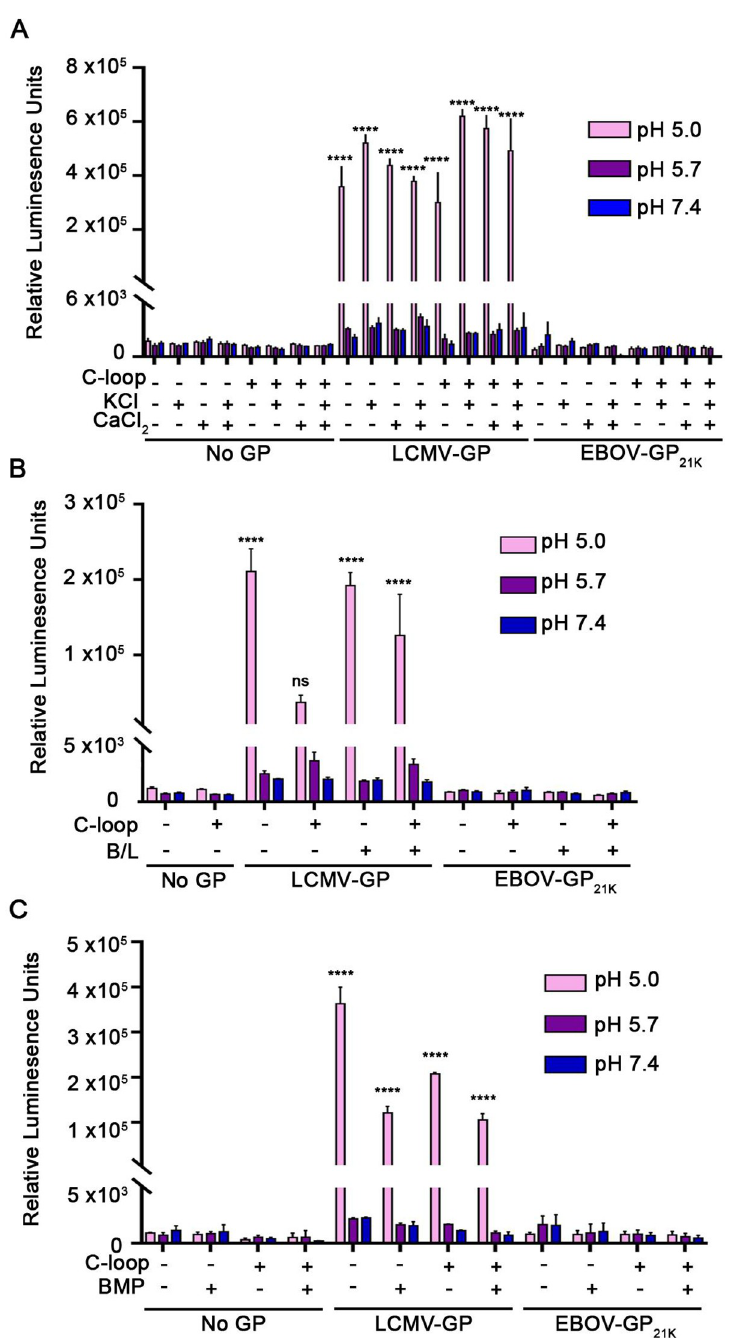
Fig 4. Addition of cations (Ca ++ , K + ), cathepsins (B and L) or an anionic lipid (BMP) does not trigger detectable fusion between cells expressing EBOV-GP cl and cells expressing NPC1 C-loop. Target and effector HEK293T/17 cells were prepared, treated and analyzed for CCF as described in the legend to Fig 1A except that the pH pulse was done, as indicated, in fusion buffer containing (A) 2 mM Ca 2+ or 140 mM K + or (B) a mixture of 5 μ g/ml of pre- activated cathepsin B and 5 μ g/ml of pre-activated cathepsin L (see S5 Fig for cathepsin activities). (C) Effector and target HEK293T/17 cells were prepared as described in the legend to Fig 1A . Cocultured cells were treated with an equimolar mixture of 5 μ M BMP and delipidated BSA for 5 min at 10˚C, and then subjected to a 5 min pulse at 37˚C at the indicated pH. Results in each panel represent mean +/- SD of triplicate samples from one of two experiments with similar results. Statistical analyses are based on two-way ANOVA tests; samples were compared to respective No GP samples. ���� p <